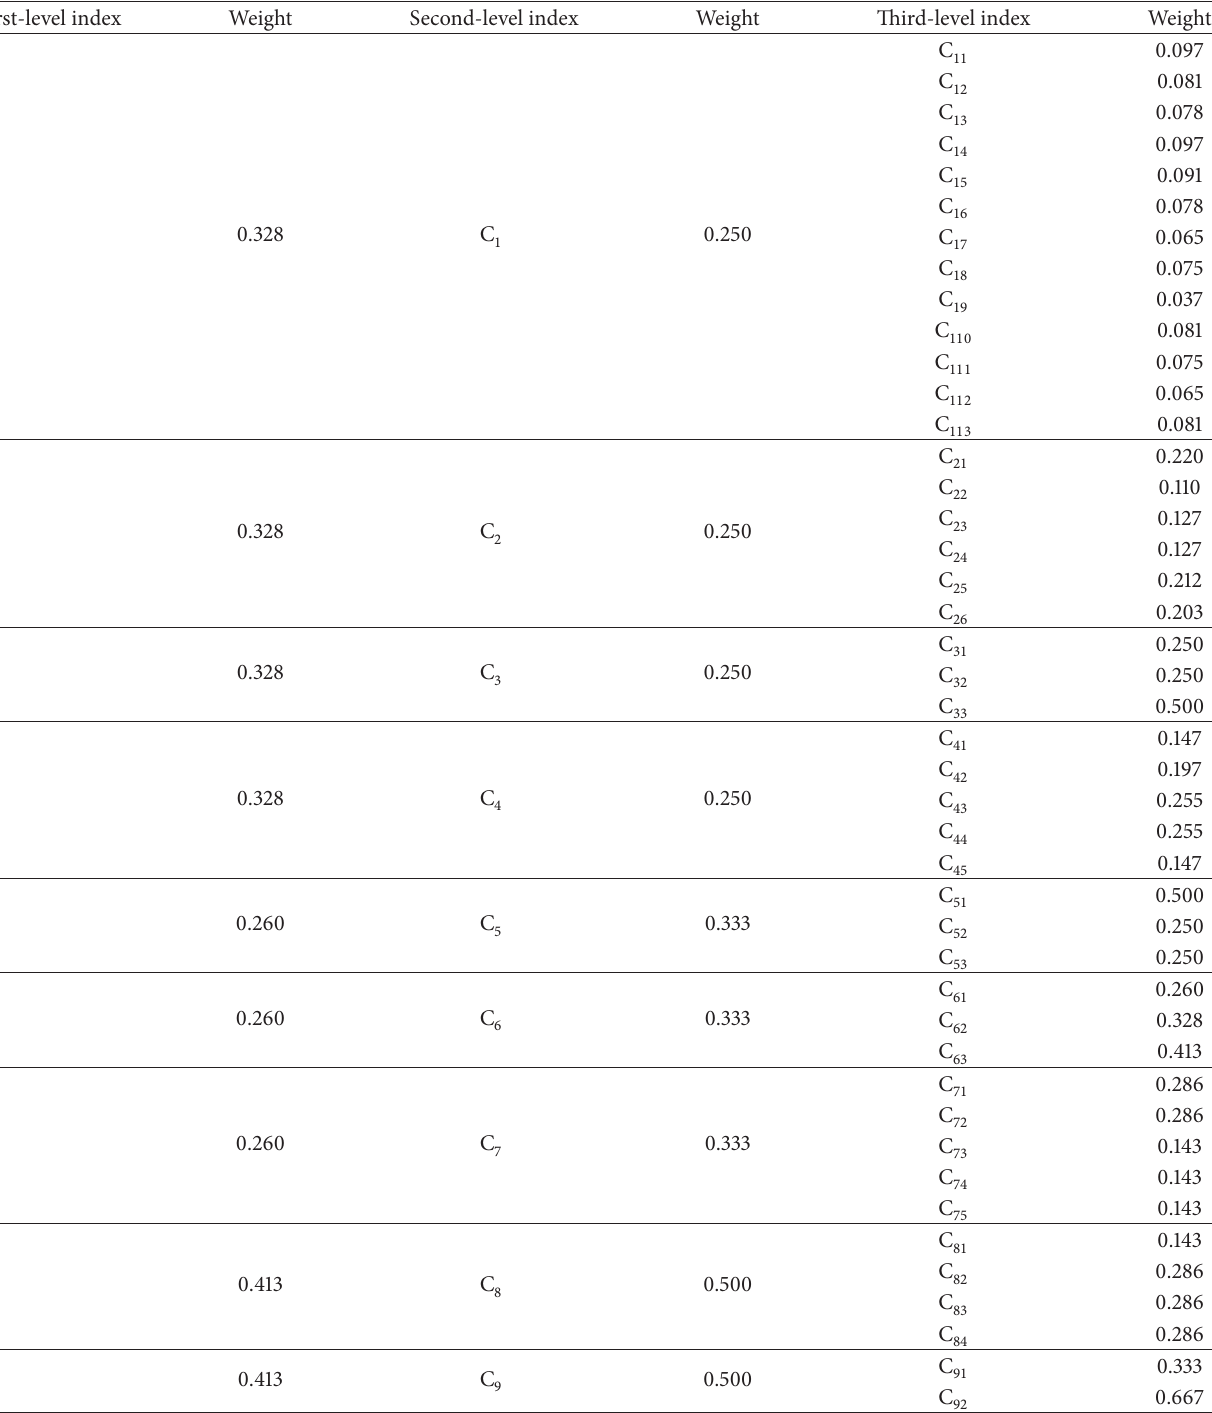
Table 7: Index weight.